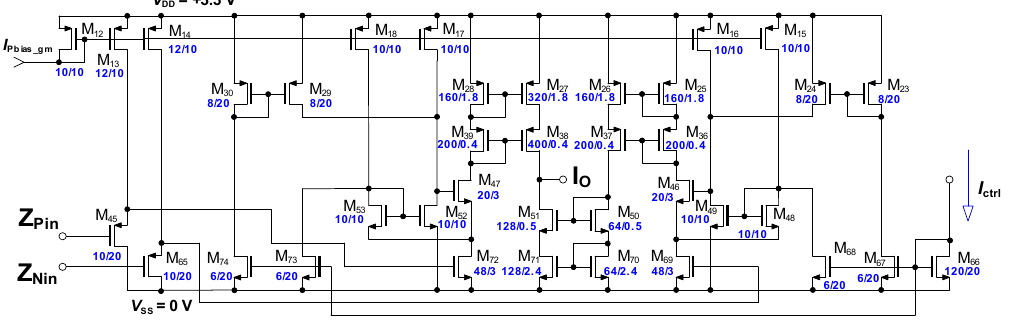
Figure 5. Slightly simplified schematic of the tunable transconductance stage.